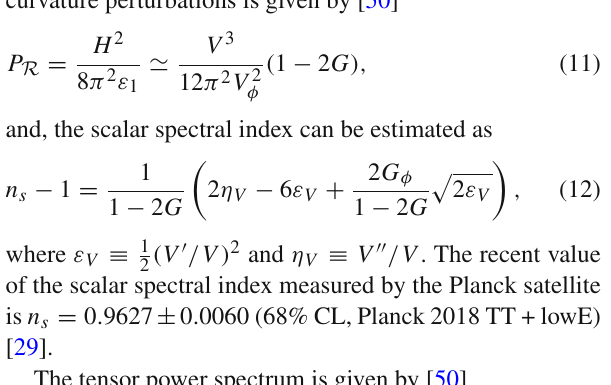
Table 1 The parameter sets for PBHs production in quartic inflation model.Theparameters φ c and c areinunitsof M pl = 1.Here, M = 0 .